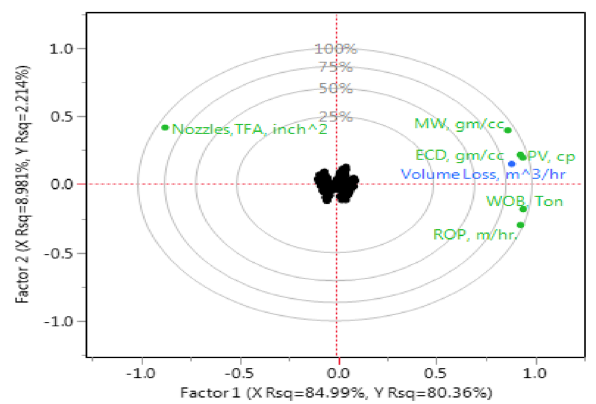
Fig. 13 Residual plot of volume loss model